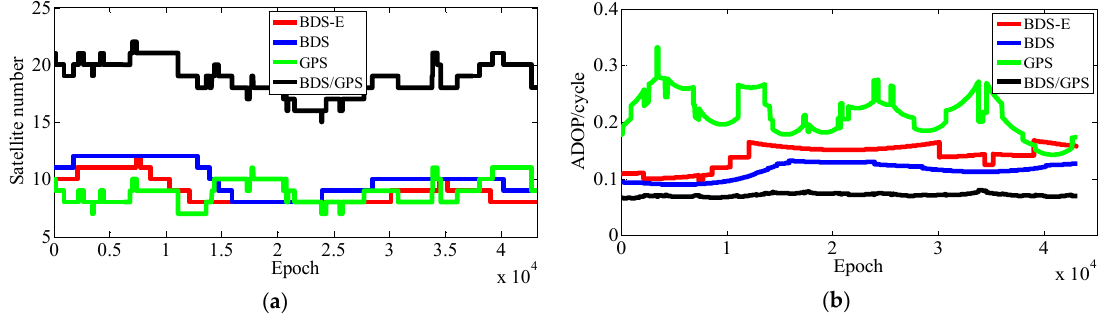
Figure 16. Satellite number and ADOP of four systems for group B. ( a ) The satellite number of four systems for group B. ( b ) The ADOP of four systems for group B.